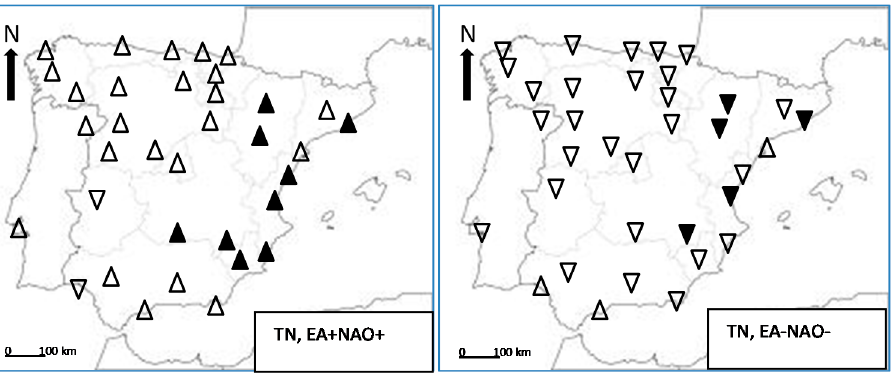
Figure 6. Difference of TN mean values for EA+NAO+ and EA-NAO- composites and the mean of the complete period 1950–2019 for spring. Triangle up (down) means positive (negative) difference, full (empty) triangle means significant (not significant) difference at the 95% confidence